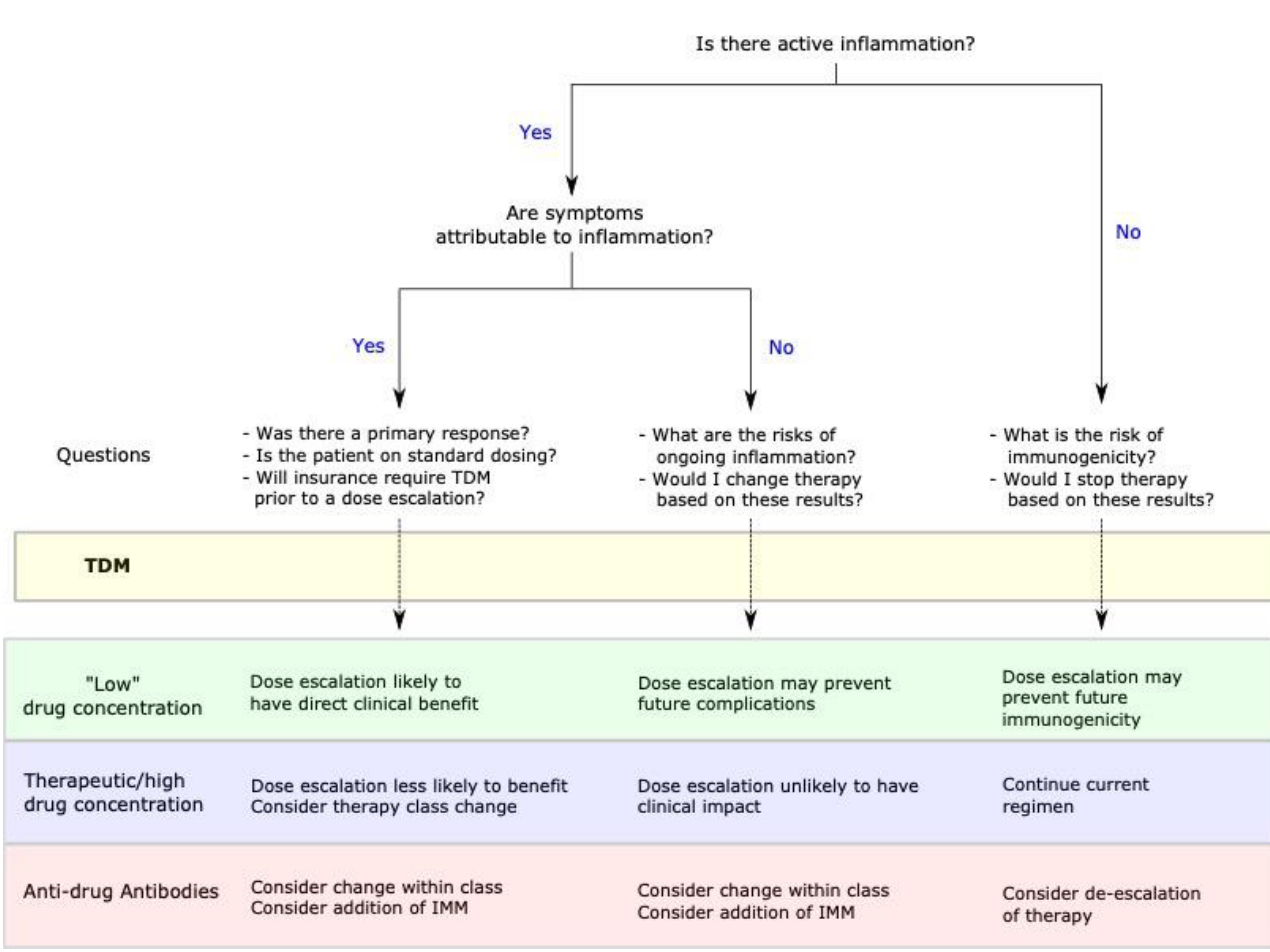
Figure 1. Algorithm of key questions to consider prior to implementing therapeutic drug monitoring (TDM) in clinical practice. Clinical benefit refers to immediate symptomatic improvement. Clinicians should have a clear understanding of the disease status prior to TDM and be able to articulate to the patient the benefit of a dose change in response to the natural history of the disease. In some cases of low-level antibodies, it may be appropriate to add an immunomodulator (IMM) to the current therapy to eliminate anti-drug antibodies. This choice should be individualized based on other available therapies and risks of dual immunosuppression for patient.